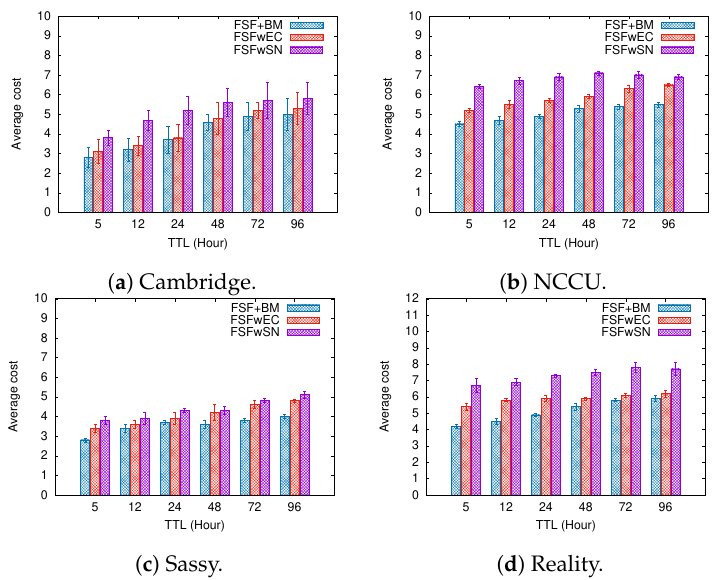
Figure 13. Average cost when increasing the message TTL.